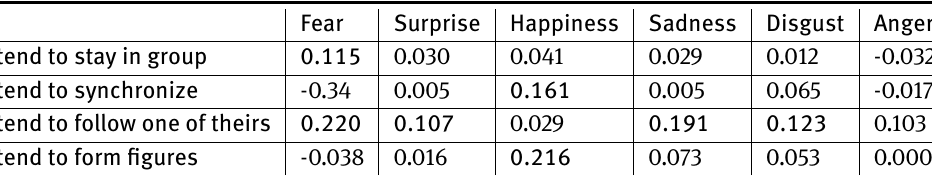
Table 7: Correlation scores for the six sequence ( τ b ). Fear Surprise Happiness Sadness Disgust Anger tend to stay in group 0.115 0.030 0.041 0.029 0.012 -0.032 tend to synchronize -0.34 0.005 0.161 0.005 0.065 -0.017 tend to follow one of theirs 0.220 0.107 0.029 0.191 0.123 0.103 -0.038 0.016 0.216 0.073 0.053